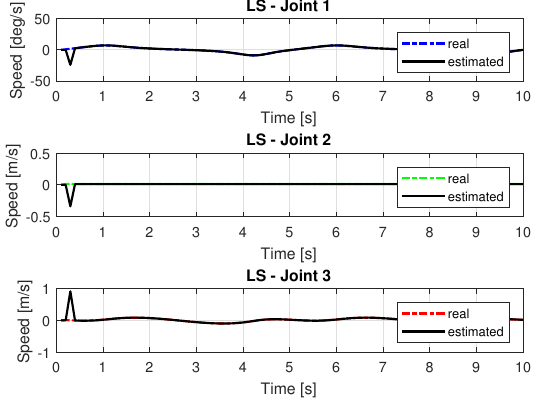
Figure 8. Speed of joints with